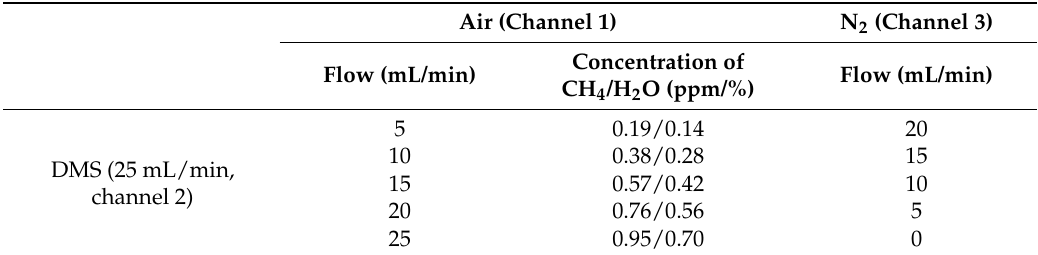
Table 3. The reference concentration settings of three gases in the second